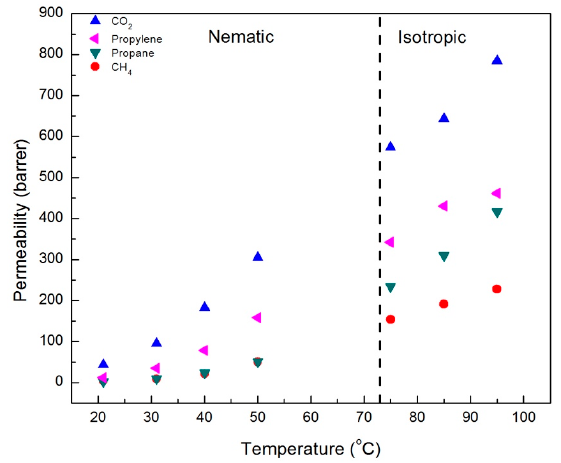
Figure 5. Single gas permeabilities for membrane CNBPh75_2.5 (2.5% crosslinker) plotted as a function of temperature in the nematic and isotropic phases.